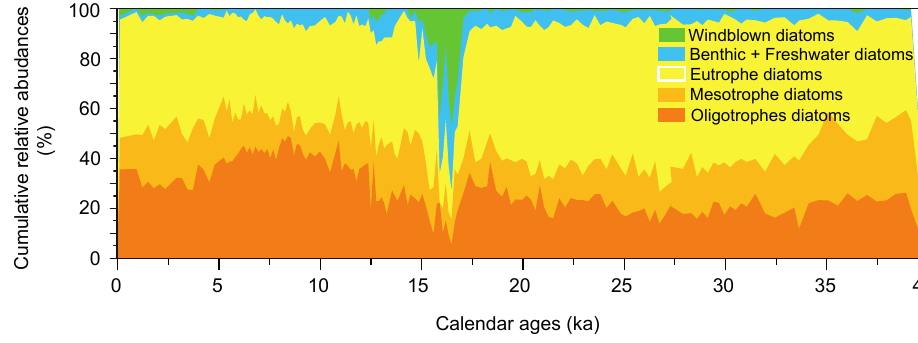
Fig. 4. Cumulative relative abundance of the five diatom groups in core GeoB4905-4 versus calendar ages.